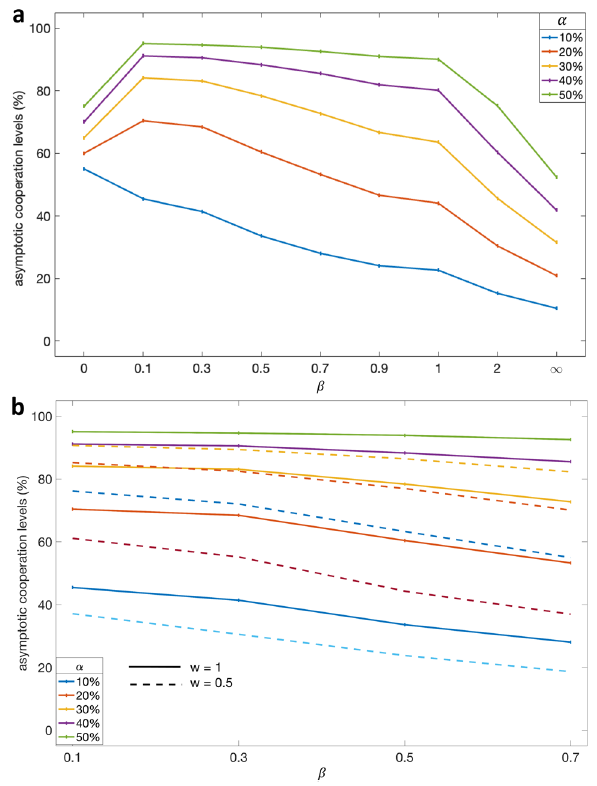
Figure 2. Asymptotic cooperation levels. a , The x-axis represents the percentage of altruists, the y-axis represents the average cooperation level over the last 5000 generations out of 20,000 with w = 1 , with each color corresponding to a different level of noise, β . b , The same as ( a ) but for w = 0.5 instead of w = 1 . c , The same as ( a ) but while varying w (x-axis) and fixing α = 30%